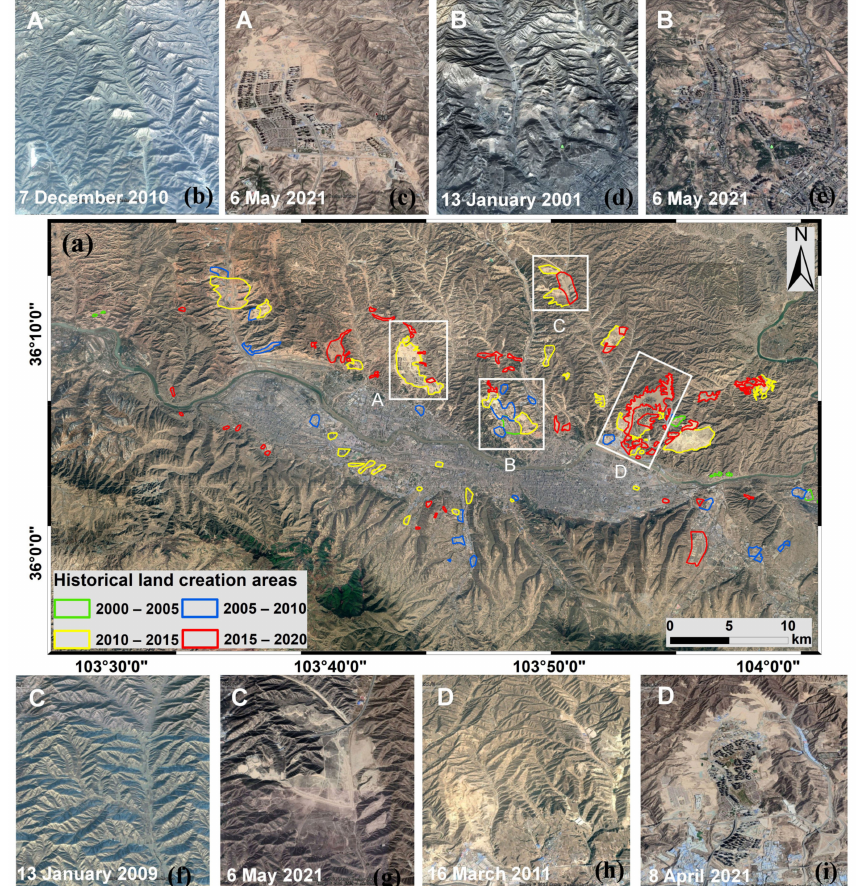
Figure 10. Spatial distribution and optical images of the historical MECC areas in Lanzhou detected by DEM errors: ( a ) spatial distribution of MECC areas in different time periods marked by different color polygons; ( b , c ) are the enlarged optical images of Region A acquired on 7 December 2010 and 6 May 2021, respectively; ( d , e ) are the enlarged optical images of Region B acquired on 13 October 2001 and 6 May 2021, respectively; ( f , g ) are the enlarged optical images of Region C acquired on 13 January 2009 and 6 May 2021, respectively; ( h , i ) are the enlarged optical images of Region D acquired on 16 March 2011 and 8 April 2021,